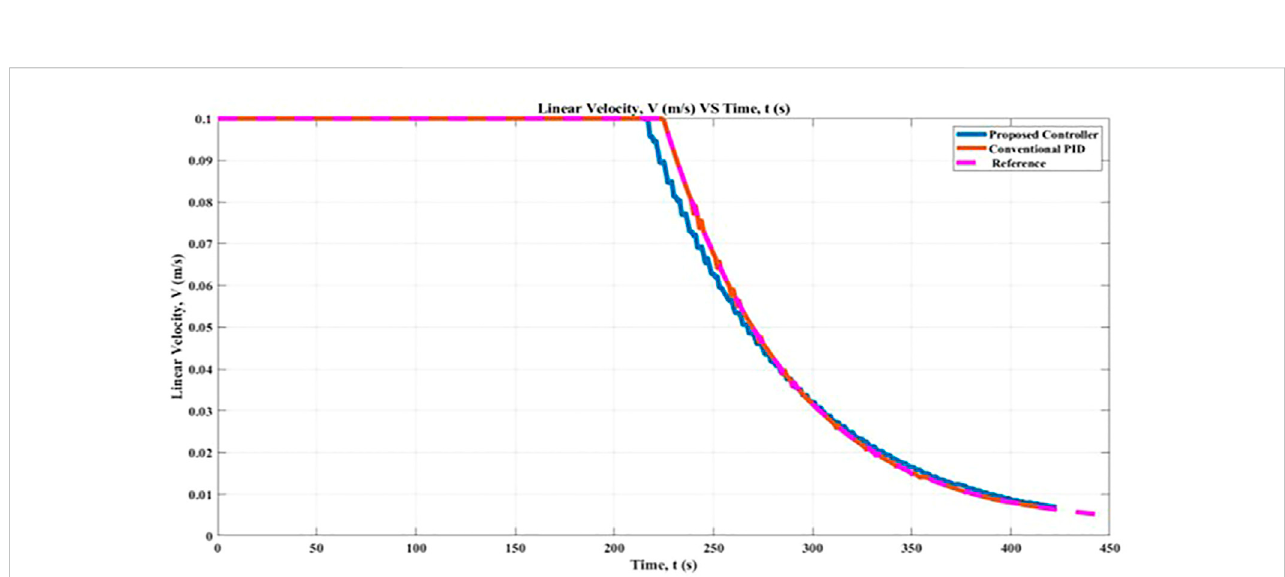
FIGURE 11 Linear Velocity, V comparison between proposed controller and conventional PID